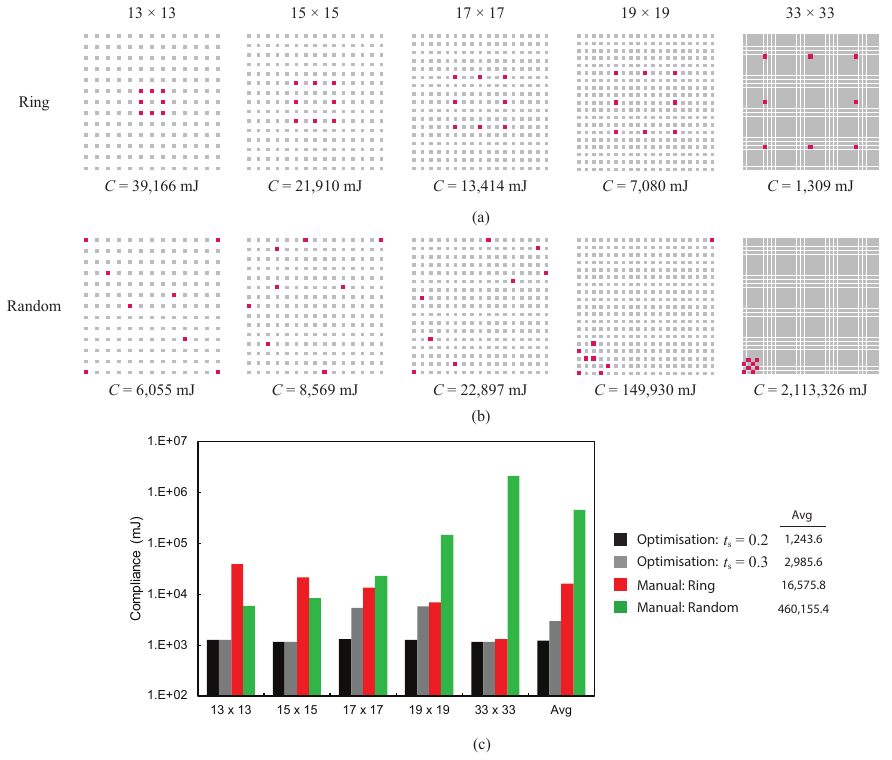
Figure 6. Manual test results of square-roof example with 8 columns arranged in ( a ) ring and ( b ) random configurations. ( c ) Summary of comparison compliance.